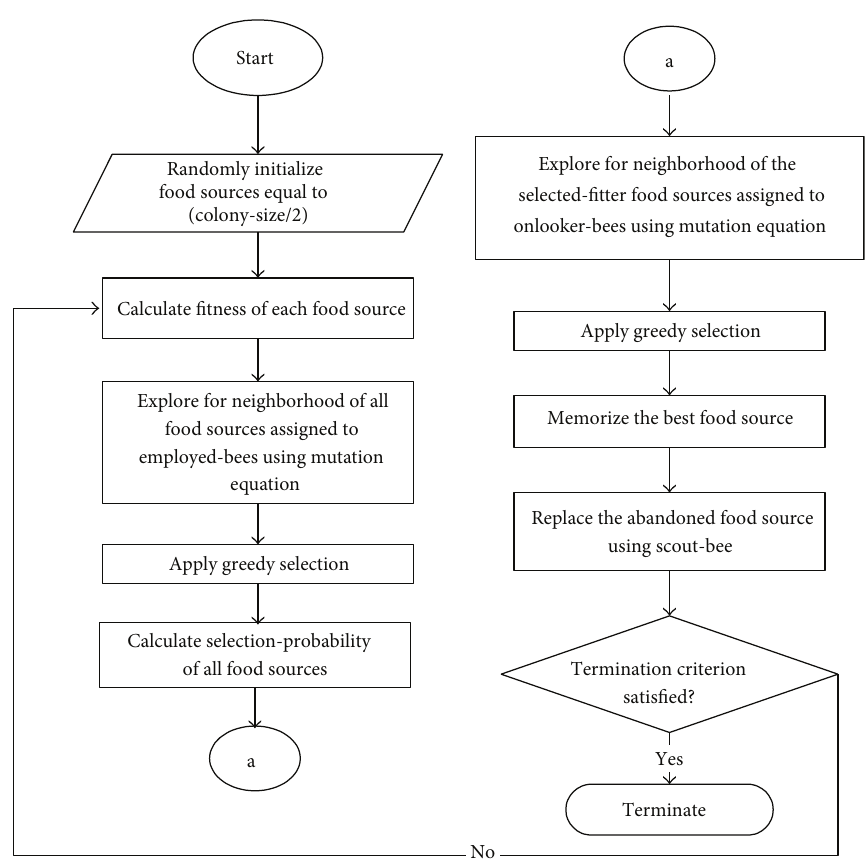
Figure 1: The flowchart of standard ABC